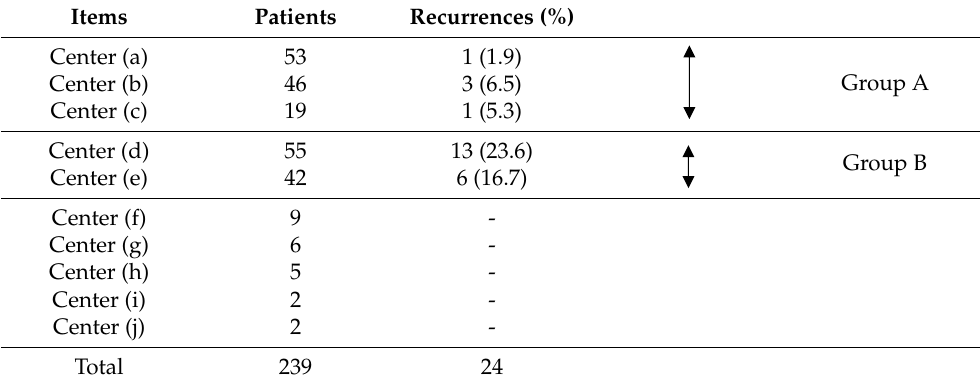
Table 1. Distribution of patients and recurrence by centers.